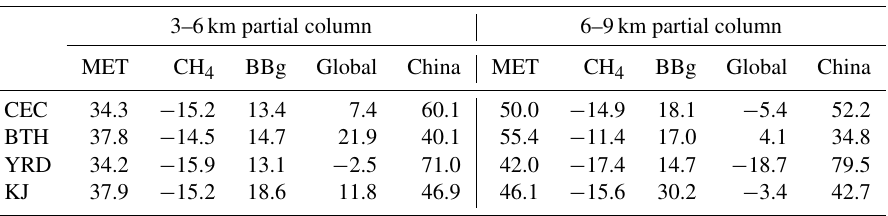
Figure 6. Trends and contributions of the meteorological variability, the Chinese anthropogenic emissions, the global anthropogenic emis- sions, the global biomass burning emissions, and the CH 4 to the trends calculated for the 3–6km (see Table 4 for details on the simulations). Table 5. Contributions (in percent) of the meteorological variability (MET), the Chinese anthropogenic emissions (China), the global an- thropogenic emissions (Global), the global biomass burning emissions (BBg), and the CH 4 to the trends calculated for the 3–6 and 6–9km partial columns for each individual region in Fig.